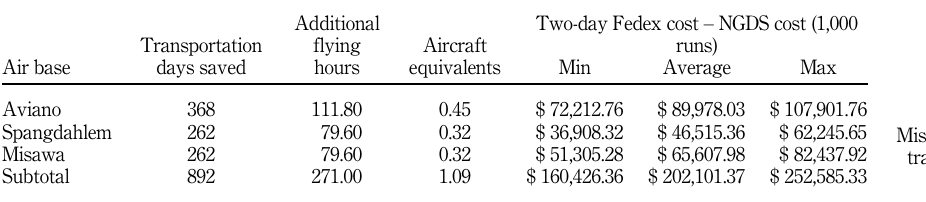
Table 1. Mission critical parts